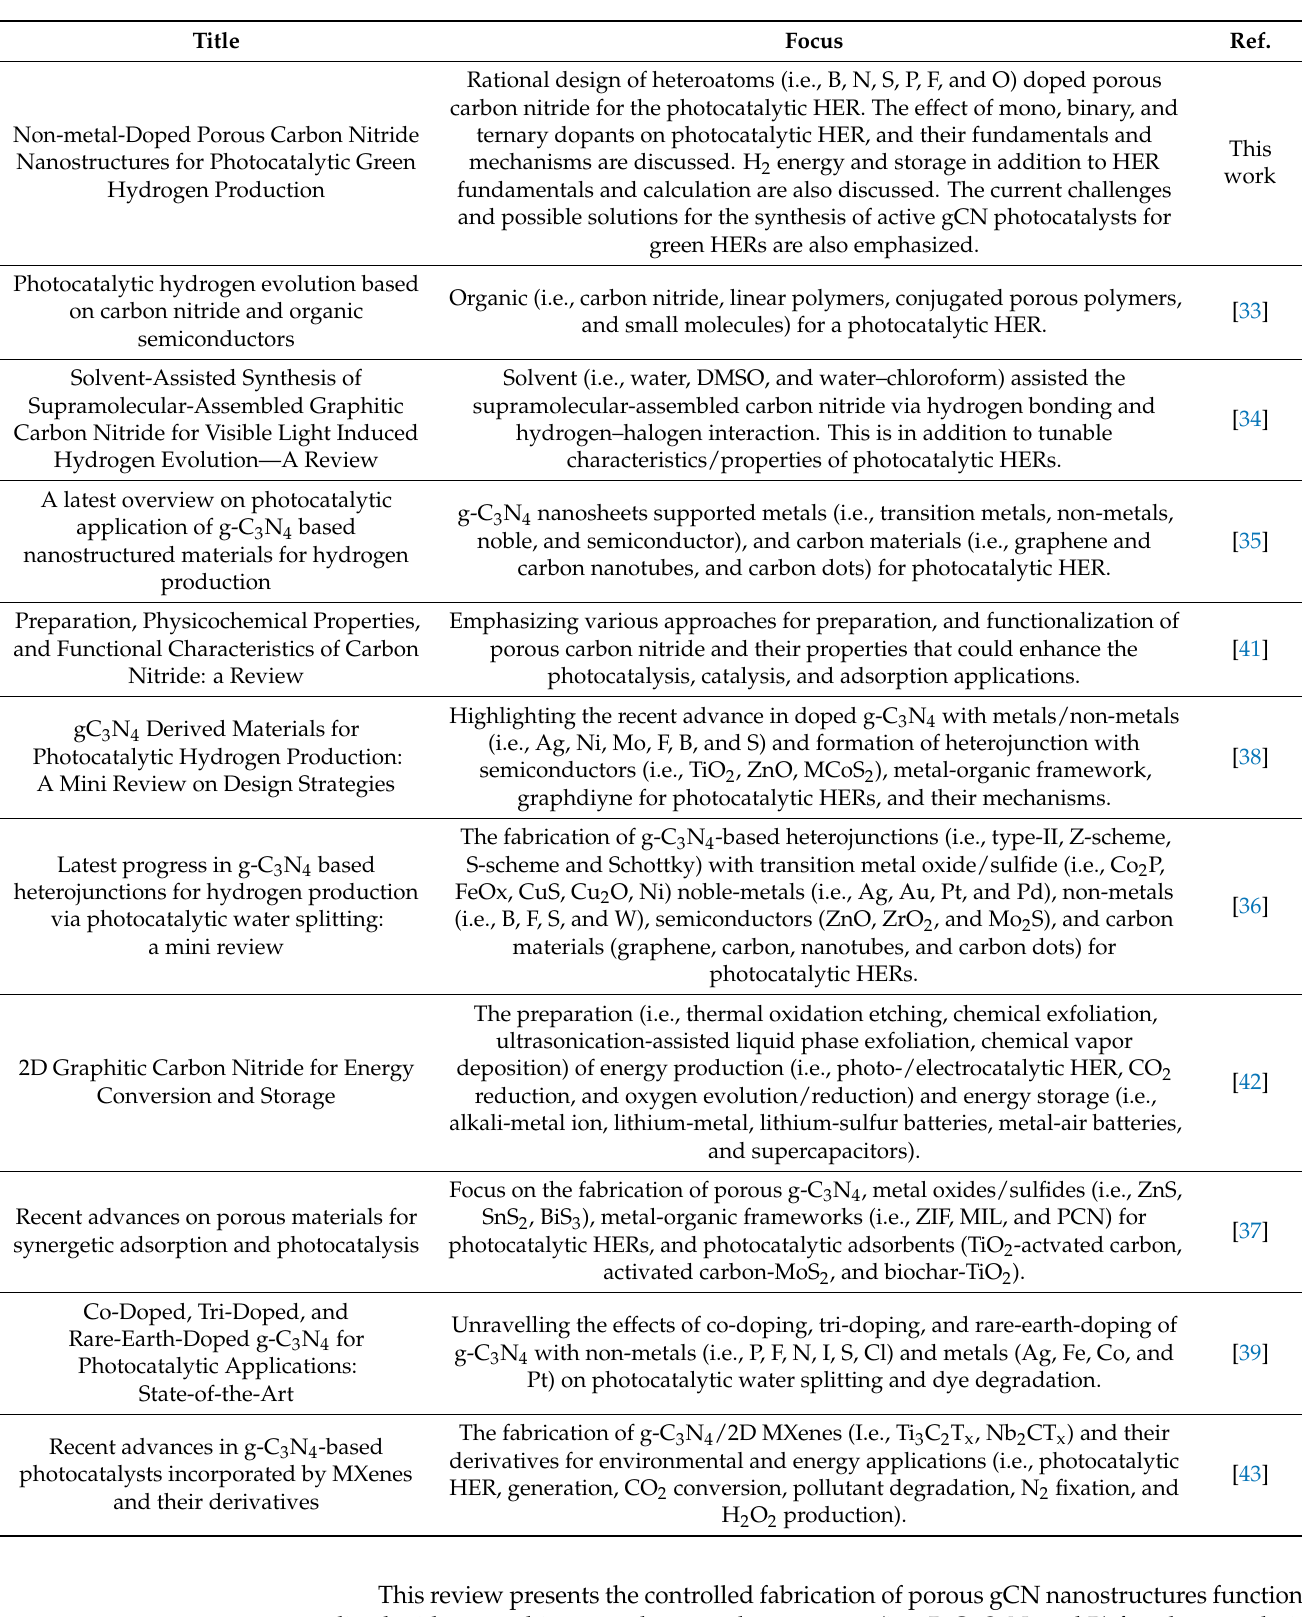
Table 1. Summary of the main reviews related to porous heteroatom-doped porous carbon nitride- based nanostructures for photocatalytic HER compared in the present